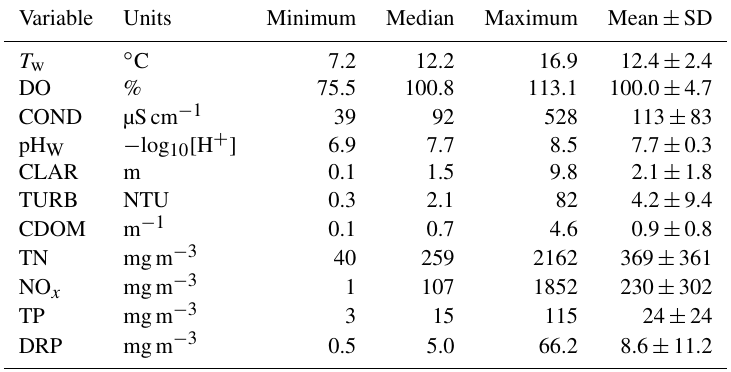
Table 5. Statistical description of medians of water quality variables for the 77 NRWQN catchments. Note that the ratio of mean/median can be used as an index of data